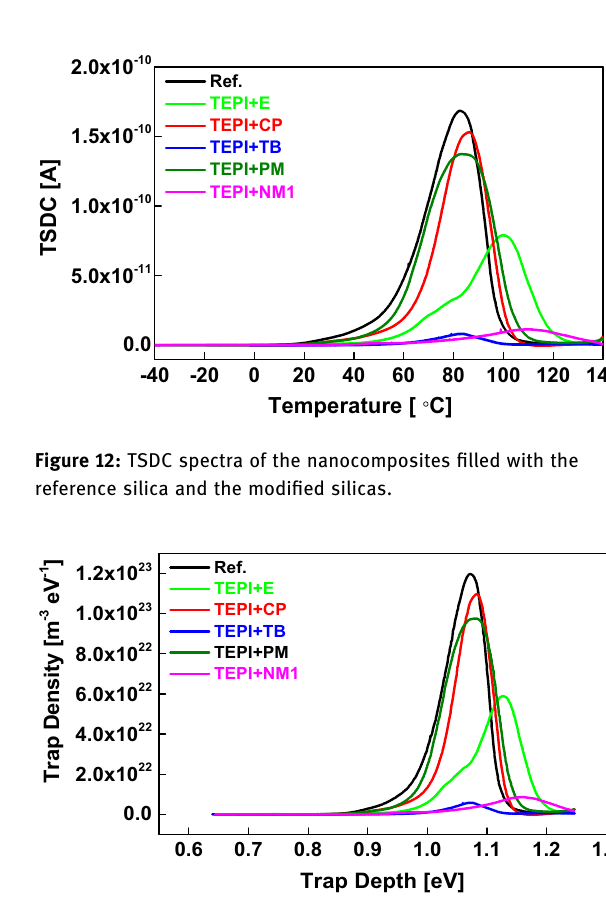
measurements were performed, and the results are pre - sented in Figure 12. The calculated trap depth and trap density by using a numerical method ( 16 ) are shown in Figure 13. The relaxation of the trapped charges contri - butes to the current during the thermal depolarization process. The TSDC temperature and current intensity are associated with the trap depth and density, respec - tively. The TSDC main peak temperatures and current intensities of the composites are shown in Table 3. Com -